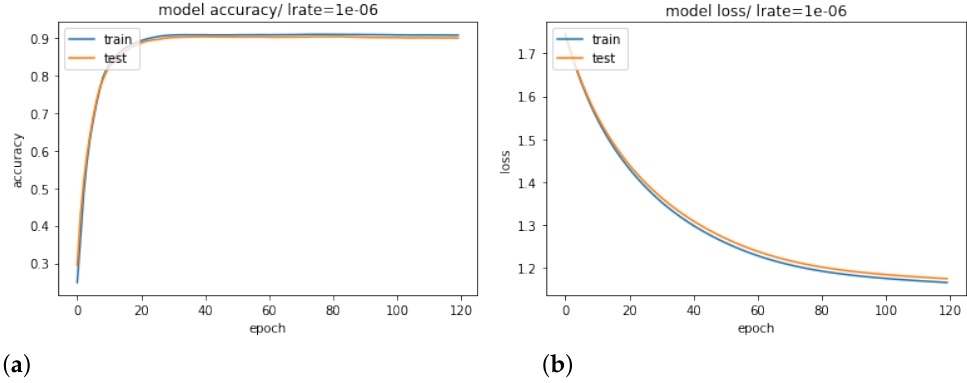
Figure 12. lr = 1 × 10 − 6 . ( a ) Train accuracy: 0.907. ( b ) Test accuracy: